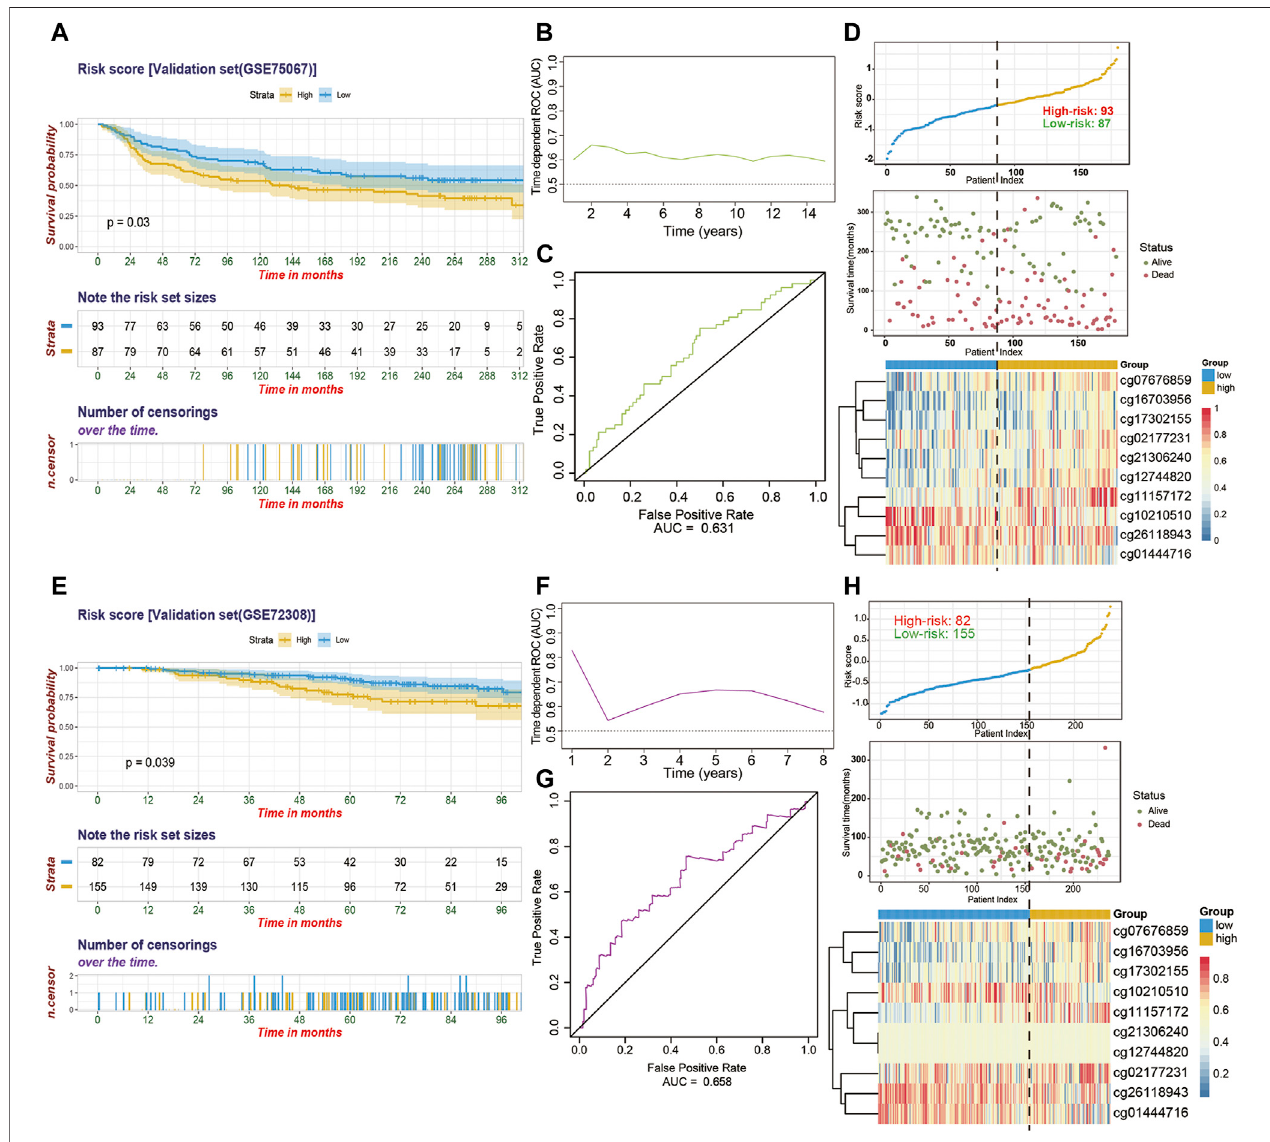
FIGURE 5 | The performance of the 10 - CpG-based signature in validation set 1 (GSE75067) and validation set 2 (GSE72308). (A) Kaplan-Meier curves depicting thesigni fi cantdifferenceofoverallsurvivalbetweenlow-andhigh-riskpatientsstrati fi edby10 - CpG-basedsignatureinGSE75067cohort.Log-ranktest, p -value (cid:1) 0.03. (B) Time-dependent ROC curves with AUC values estimated of the prognostic signature in GSE75067 cohort from 1 year to 15 years. (C) The 5-years ROC analysis of the prognostic signature in GSE75067 cohort. (D) The relationship among the distribution of patients ’ risk score (upper), survival status (middle), and the methylationpatternofthe10particularCpGsites(bottom)inGSE75067cohortisshown.TheKaplan-Meiersurvivalanalysis (E) ,time-dependentROCcurveswithAUC values calculated (F – G) and risk score analysis (H) for the 10 - CpG-based signature in GSE72308 cohort. Log-rank test, p -value (cid:1)